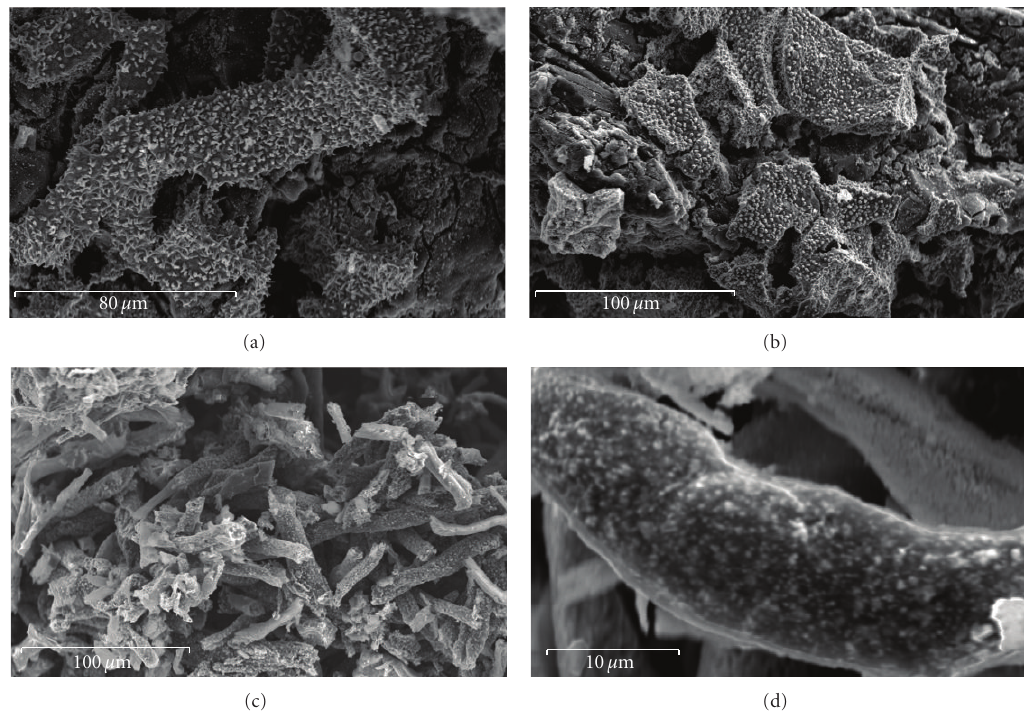
Figure 4: SEM Images of iron coated (a) MN-5, (b) MN-6, and (c-d) MN-7.